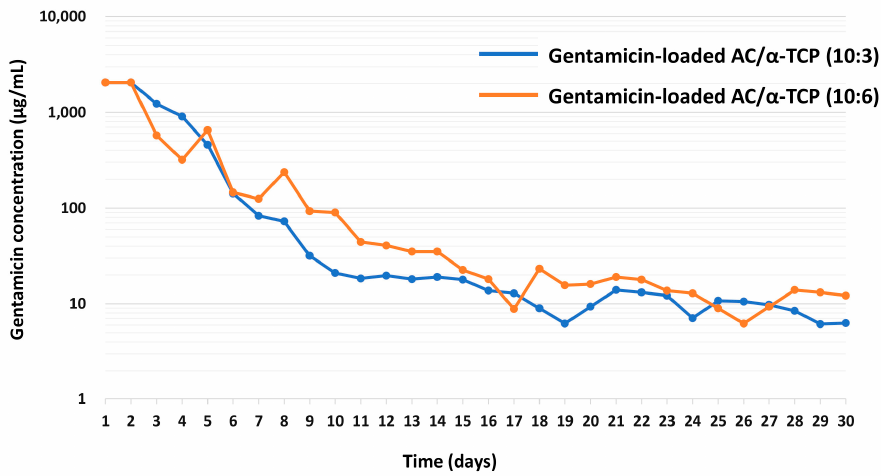
Figure 6. The concentration of gentamicin released from gentamicin-loaded AC/ α -TCP compo- sites.